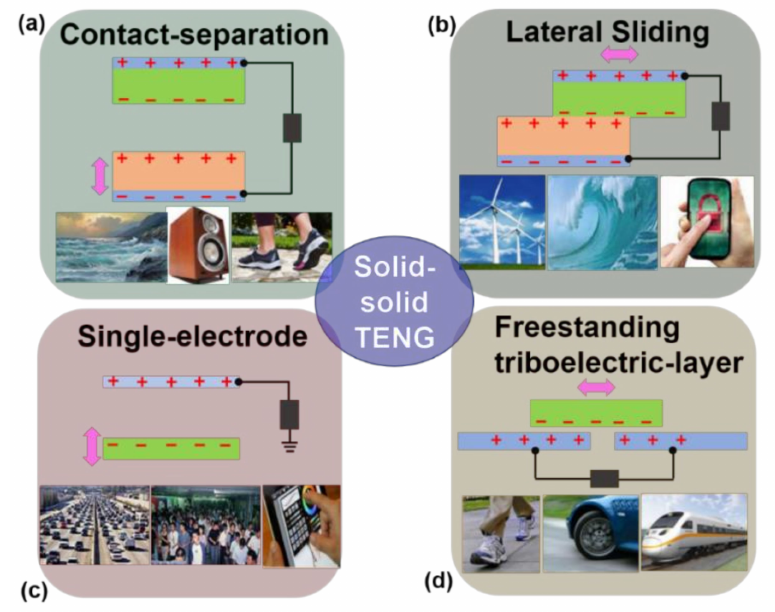
Figure 2. Four basic fundamental modes of solid–solid TENGs: ( a ) contact–separation mode; ( b ) lateral- sliding mode; ( c ) single-electrode mode; and ( d ) freestanding triboelectric-layer mode (reproduced with permission from [38] Copyright 2013 American Chemical Society, New York, NY,